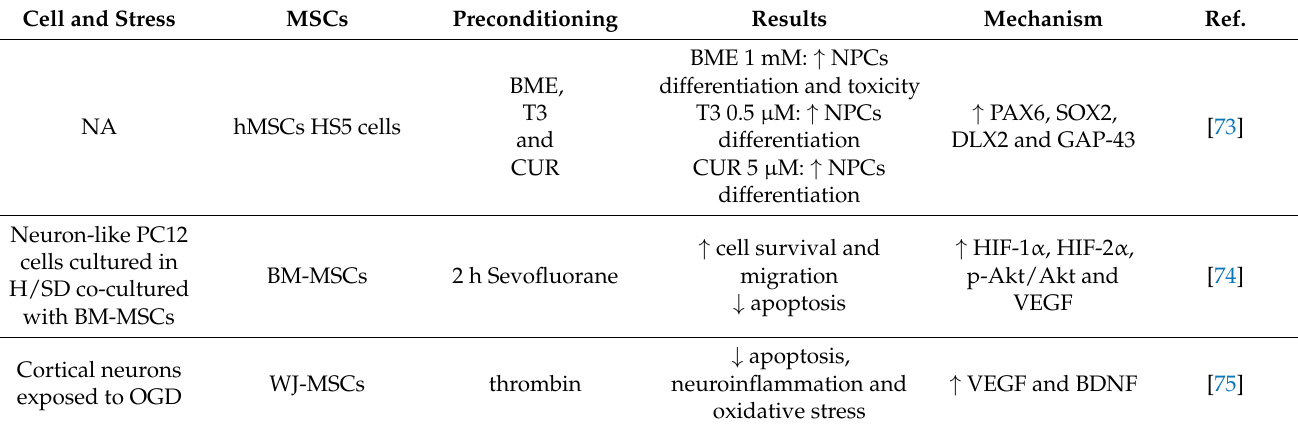
Table 4. Summary of the in vitro studies that described the effects of MSC preconditioning with chemical, pharmacological agents, trophic factors and